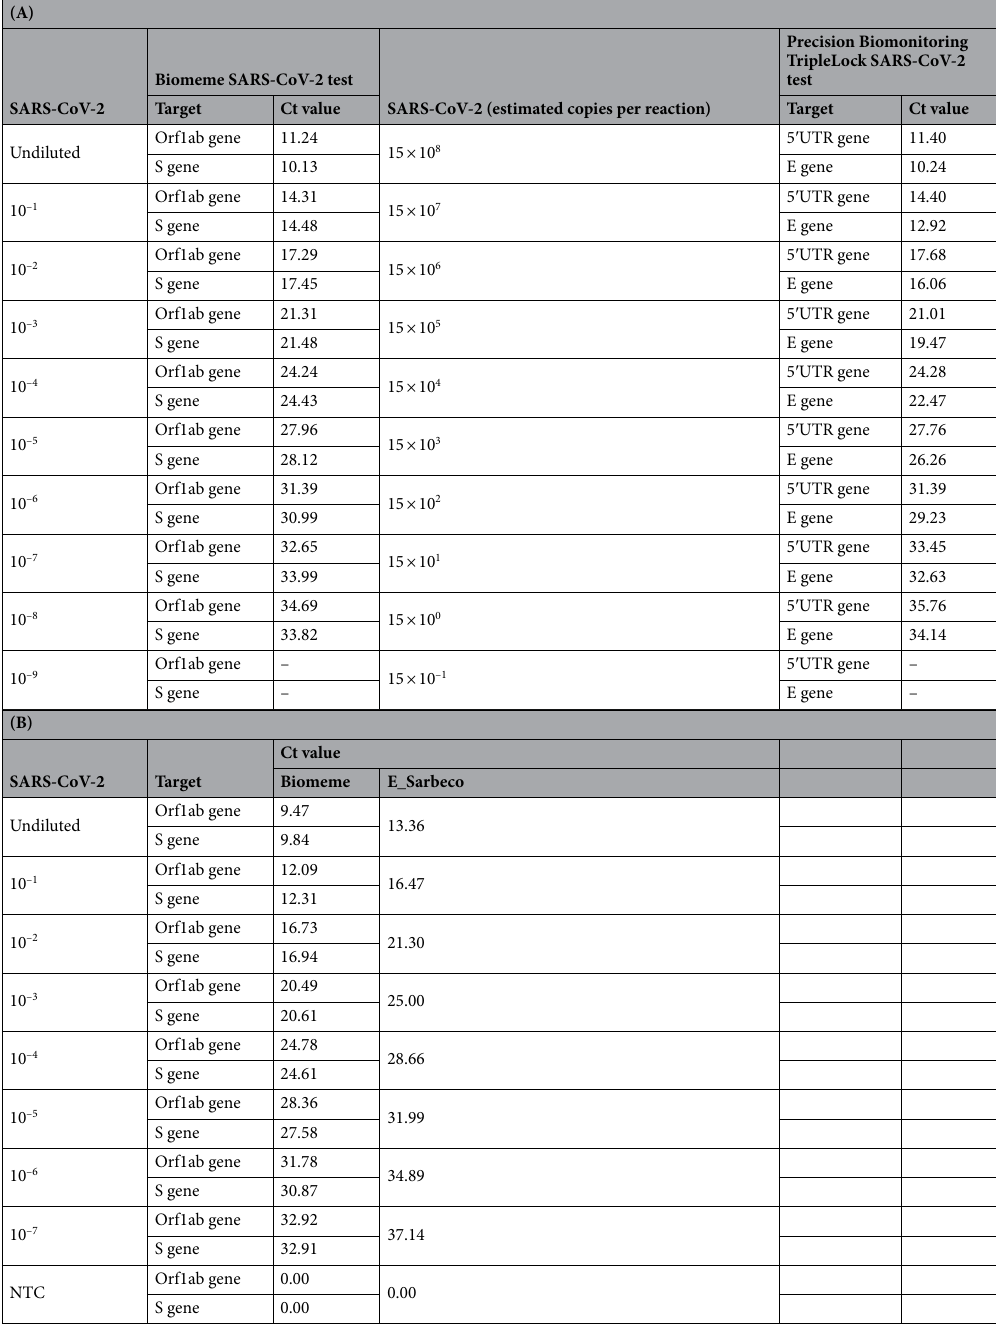
Table 1. The sensitivity and LOD of the Biomeme and Precision Biomonitoring SARS-CoV-2 tests. The M1 Sample Prep Cartridge Kit for RNA 2.0 was used to extract RNA from serial dilutions of cell culture-amplified SARS-CoV-2. Following the extractions, 20 µl of RNA from each dilution was used to set up the Biomeme and Precision Biomonitoring SARS-CoV-2 Test on Franklin three9 (A). Because the same extracted RNA from the dilutions were used for both assays, there was no spiking of RPC during extraction as required by the Biomeme assay, this was done to avoid interfering with the E gene of the Precision Biomitoring assay as both RPC and E gene are on the same channel (TexasRedX) on Franklin three9; as a result, all internal controls were excluded from the runs and analysis. In addition, the detection of the full SARS-CoV-2 targets (even in the absence of the internal controls) in both assays means that the tests are positive/valid. In another experiment, MagMAX™ CORE Nucleic Acid Purification Kit-extracted RNA from cell culture-amplified SARS-CoV-2 dilutions was used to set up Biomeme and E_Sarbeco SARS-CoV-2 assays to compare their sensitivities. The Biomeme SARS-CoV-2 assay was run on Franklin three9 while the E_Sarbeco assay was run on ABI 7500